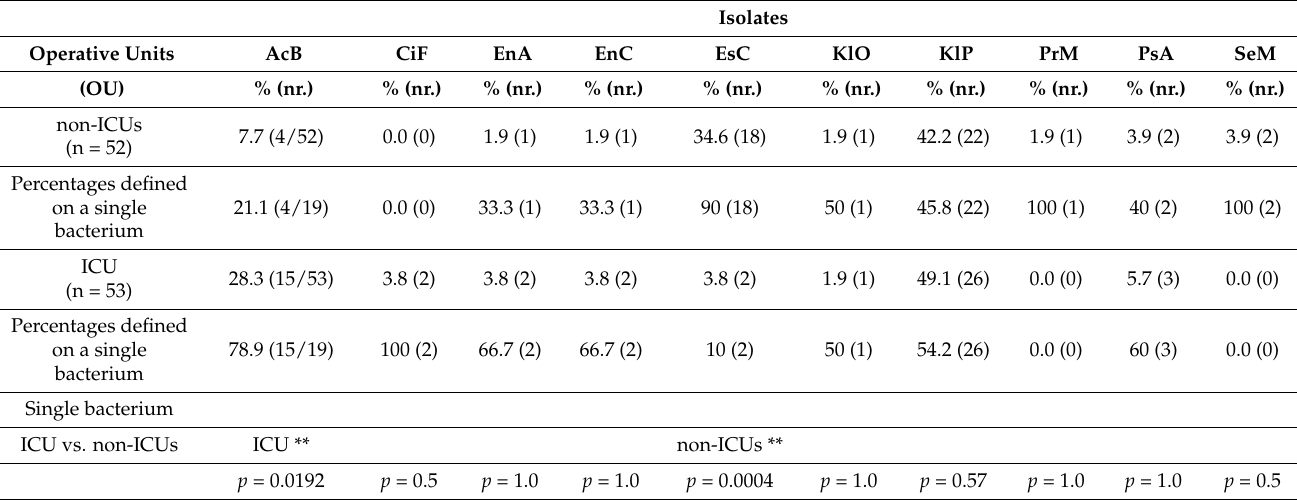
Table 3. Comparison of 105 Gram-negative bacteria (GNB) detected in non-intensive care units (non-ICUs) and the intensive care unit